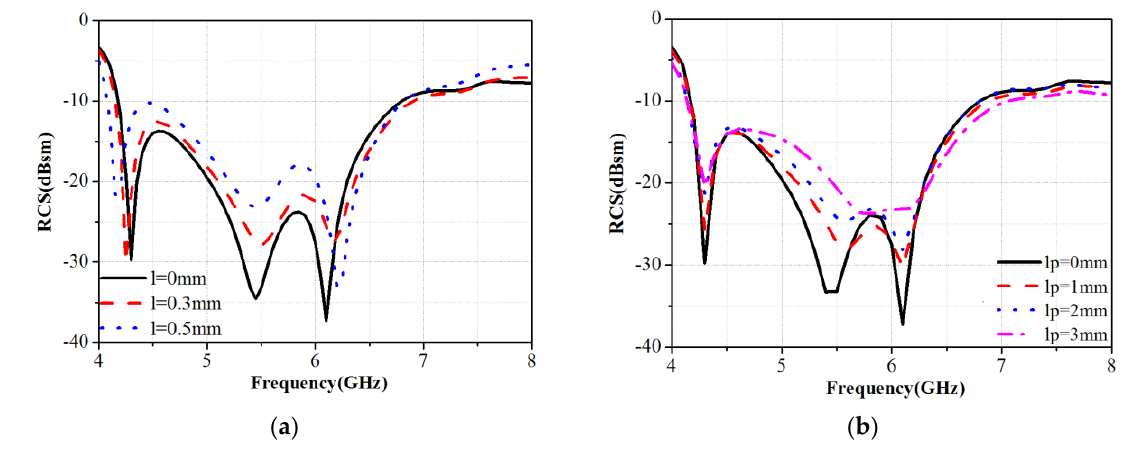
Figure 26. RCS of the array antenna in conditions of gap and displacement errors. ( a ) The space gap between the double PCB layers; ( b ) displacement between the double PCB layers.